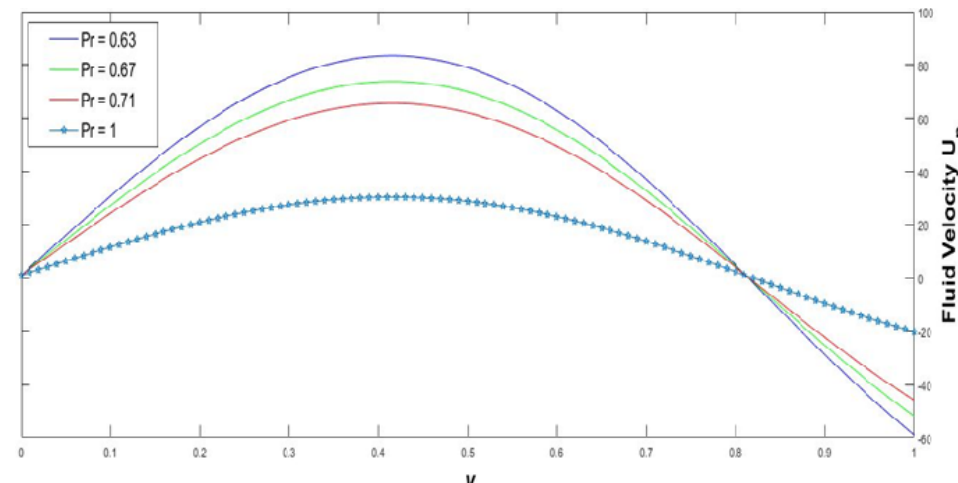
Figure 13. Velocity field for different Prandtl